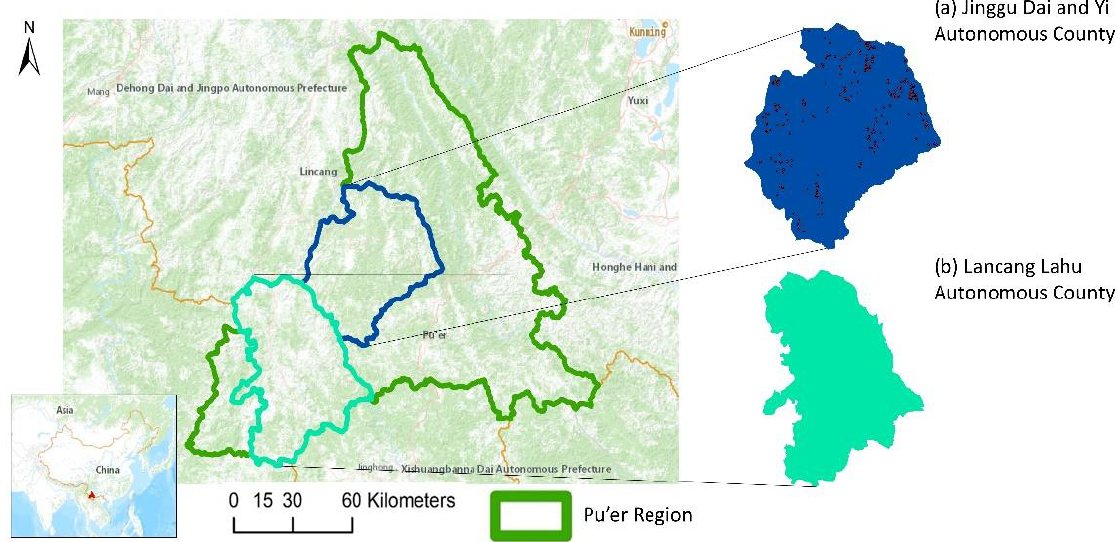
Figure 1. Location of the Pu’er region (green) and Yunnan Province (orange), China. We sampled all known ancient tea trees in Jinggu Dai and Yi Autonomous County ( a ), which was used in the training set to model the potential distribution of ancient tea trees in Pu’er. Sample points are shown to visualize their general spread. We used Lancang Lahu Autonomous County ( b ) as the test area to assess modeling accuracy.